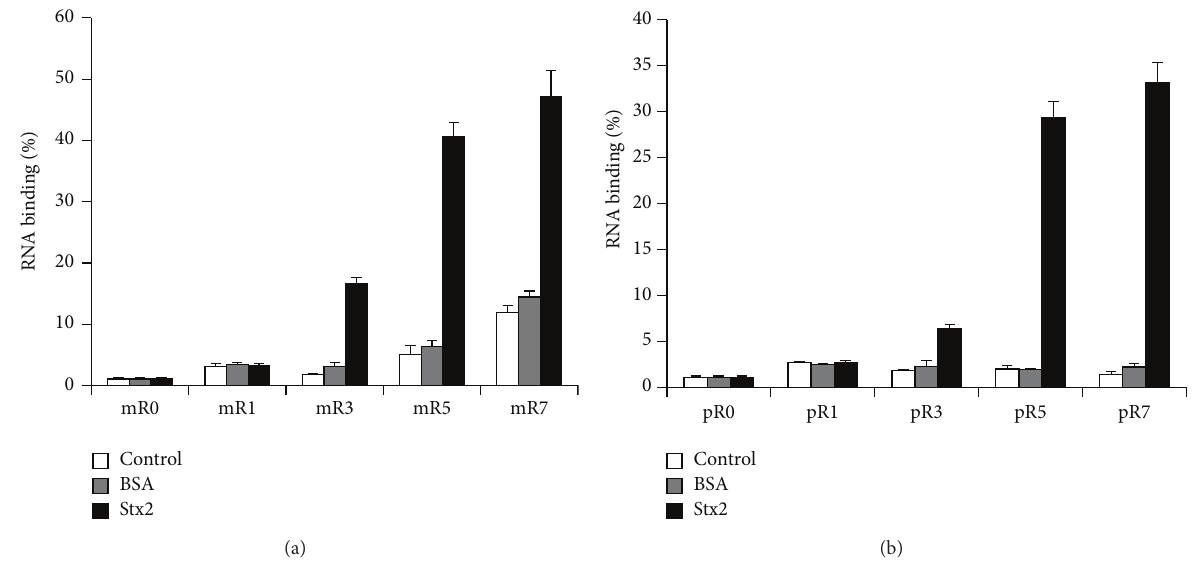
Figure 1: Enrichment of unmodified RNA aptamer pool of 56 random nucleotides for binding with Stx2 through successive selection rounds of SELEX. Binding activity of the RNA pool was analyzed by filter binding assay. Strong enrichment of aptamer pool for Stx2-binders occurred at 5th round of selection by both m-SELEX (a) and p-SELEX (b) as 41% and 29% of the input RNA bound with Stx2, respectively, whereas binding to the membrane and unrelated protein BSA was < 5%. The enrichment did not increase with additional rounds of selections. This experiment was repeated twice with similar